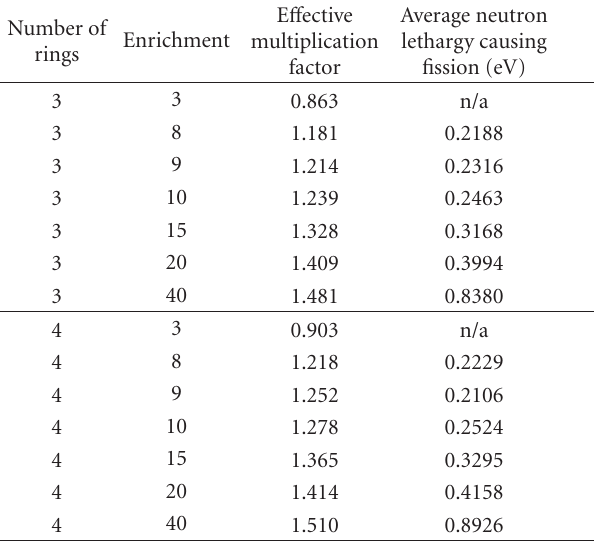
Table 3: Reactor physics parameters for three and four ring LEU- VHTR configurations.